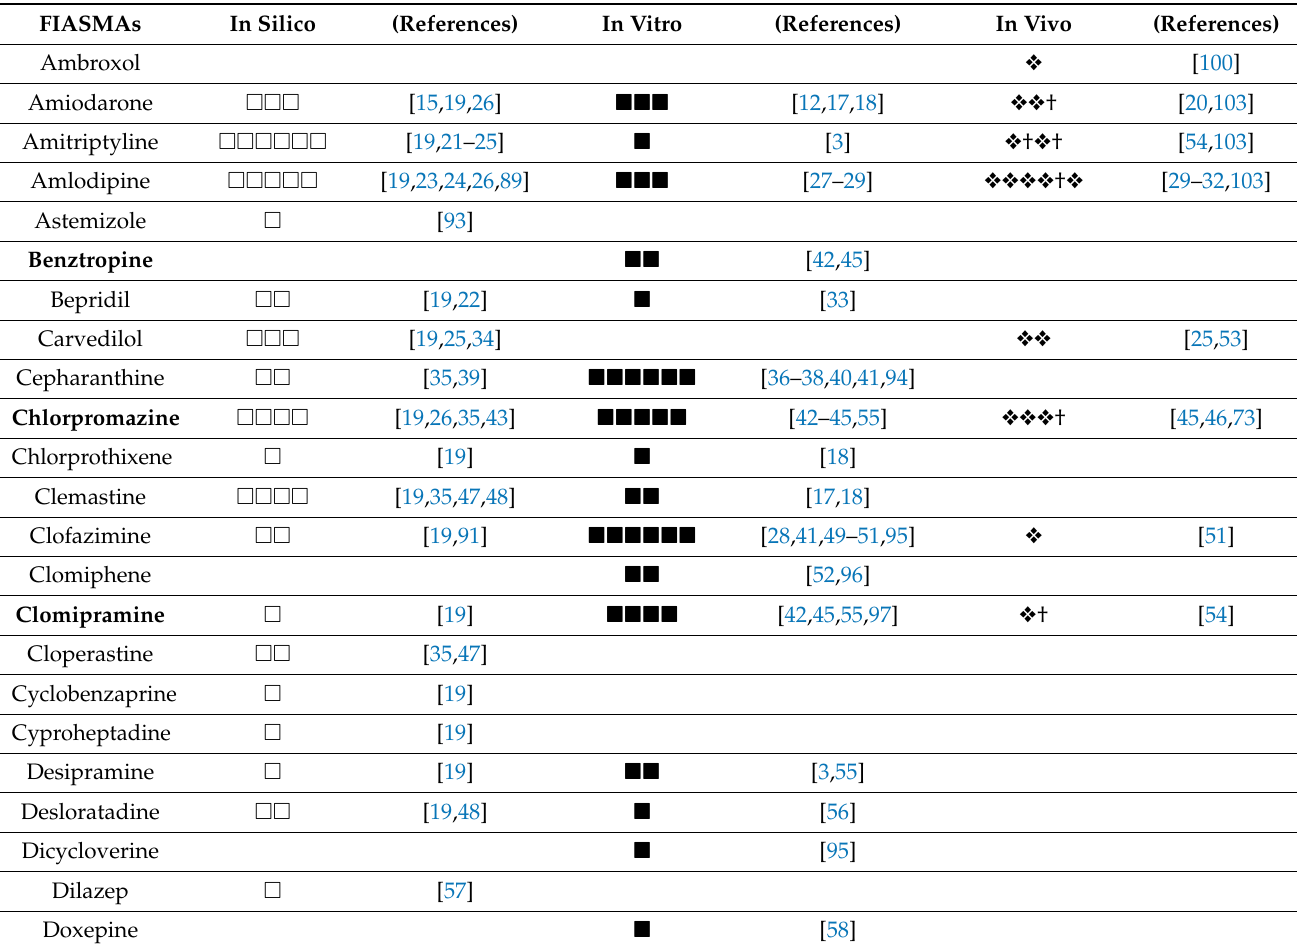
Table 1. Functional inhibitors of acid sphingomyelinase (FIASMAs) with activity against SARS-CoV-2 on in silico, or/and in vitro models or/and in vivo models (N =